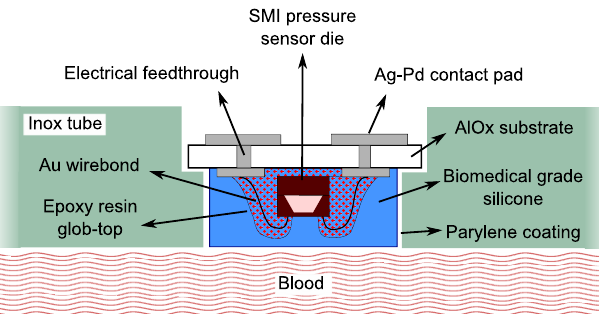
Figure 1. Schematic overview of the sensor embedded in the VAD connector tube.